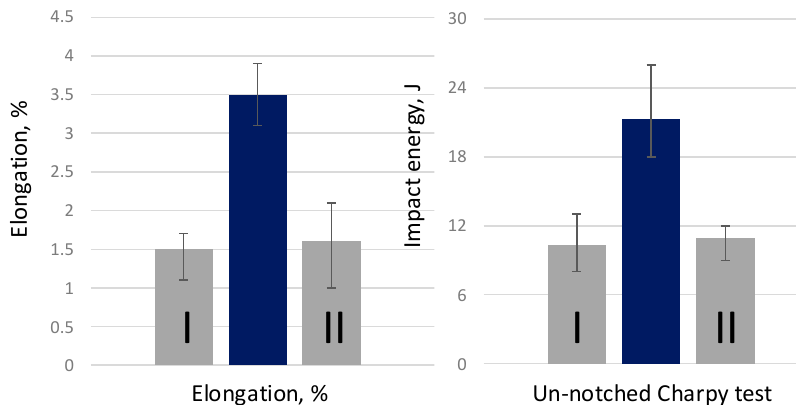
Figure 12. Comparison of the mechanical properties of the AM and PM specimens, I for PM1 and, II for PM2.